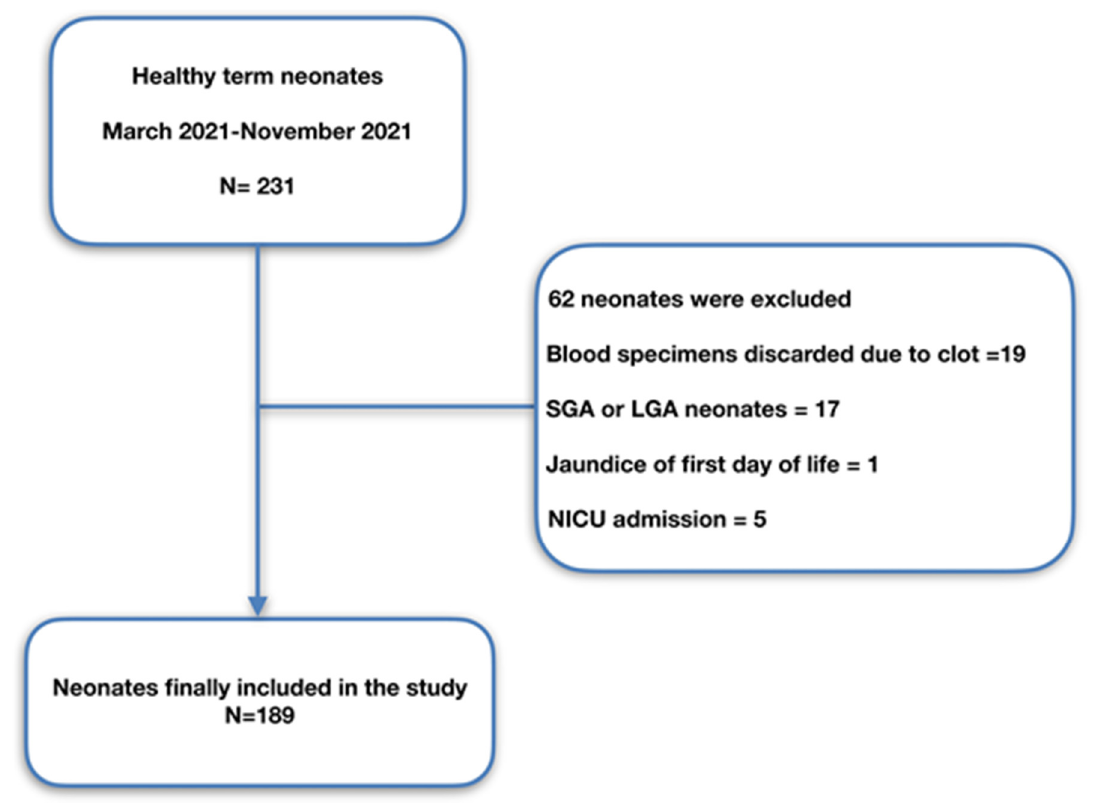
Figure 1. Study population flowchart. SGA, small for gestational age; LGA, large for gestation age; NICU, neonatal intensive care unit.